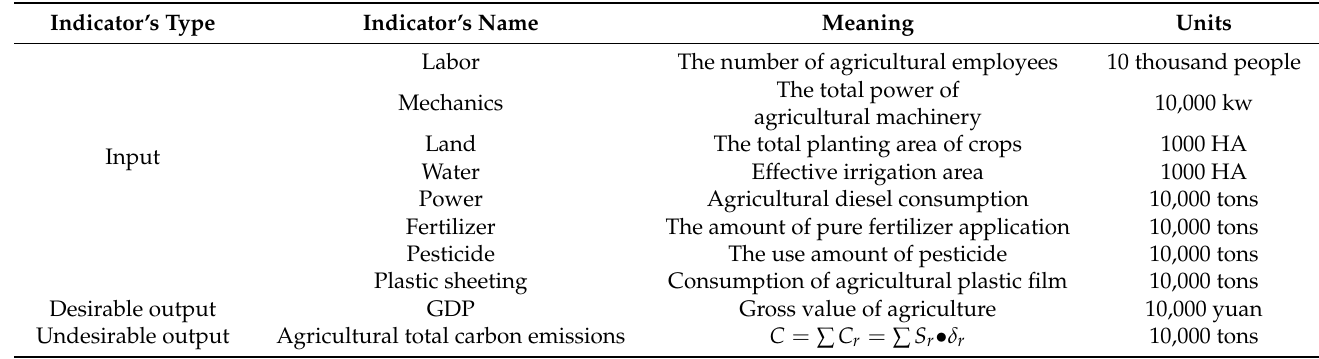
Table 1. The input–output indicators system of AGTFP.